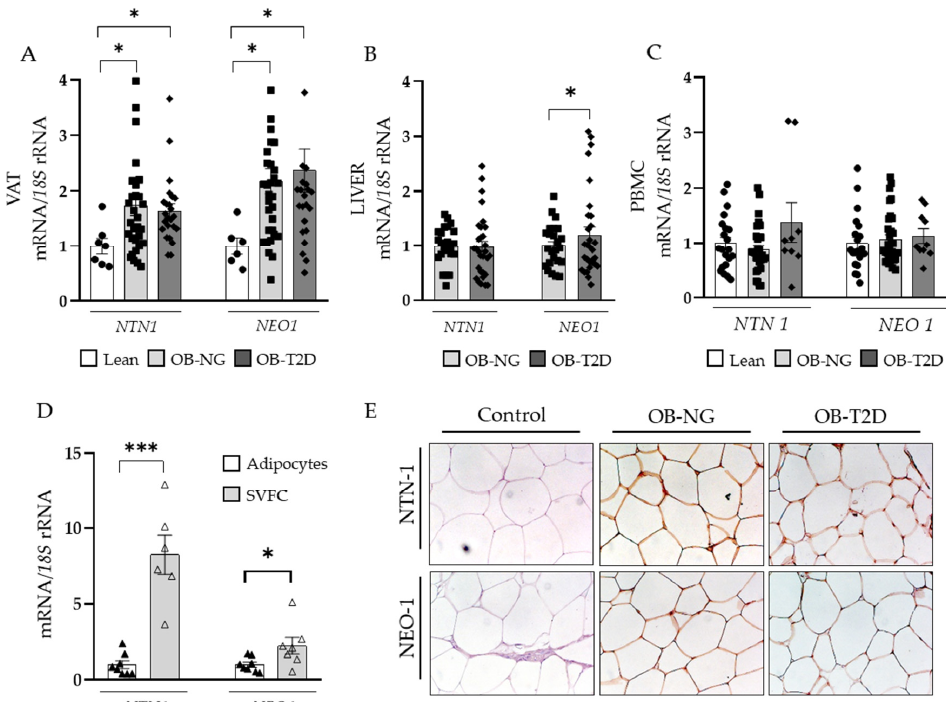
Figure 2. Gene expression levels of NTN1 and NEO1 in ( A ) visceral adipose tissue (VAT, LN n = 7, OB-NG n = 31, OB-T2D n = 24), ( B ) liver (OB-NG n = 18, OB-T2D n = 24), and ( C ) peripheral blood mononuclear cells (PBMC, LN n = 21, OB-NG n = 30, OB-T2D n = 10) from lean volunteers (LN), patients with obesity and normoglycaemia (OB-NG) and patients with obesity and T2D (OB-T2D). ( D ) mRNA levels of NTN1 and NEO1 in adipocytes ( n = 8) and stromal vascular fraction cells (SVFC n = 6–7) and ( E ) immunohistochemical detection of NTN-1 and NEO-1 in VAT obtained from patients with OB and with and without T2D (magnification 20X). Bars represent the mean ± SEM. Differences between groups were analyzed by one-way ANOVA followed by Tukey’s post hoc tests or unpaired Student’s t-test, where appropriate. * p < 0.05 and *** p < 0.001. 3.4. NTN1 and NEO1 Are Associated with ECM Remodelling and Inflammation in VAT Table 4. Gene expression levels of inflammation- and extracellular matrix-related factors in human Given the role of NTN-1 and NEO-1 in cell migration [9], we analyzed their association with relevant genes related with ECM remodeling in VAT. Patients with OB visceral adipose showed increased mRNA expression levels ( p < 0.05) of the ECM genes MMP9 , TNC, and TGFB with the latter being also upregulated ( p < 0.001) in T2D patients compared to NG subjects (Table 4). A positive correlation of the gene expression levels of NTN1 and NEO1 with MMP2 (r = 0.35 and r = 0.42, respectively; p < 0.01) and TGFB (r = 0.32 and r = 0.30, respectively; p < 0.05) was found. NEO1 gene expression levels were also associated to TNC (r = 0.45; p < 0.01) and TNF (r = 0.32; p < 0.01).